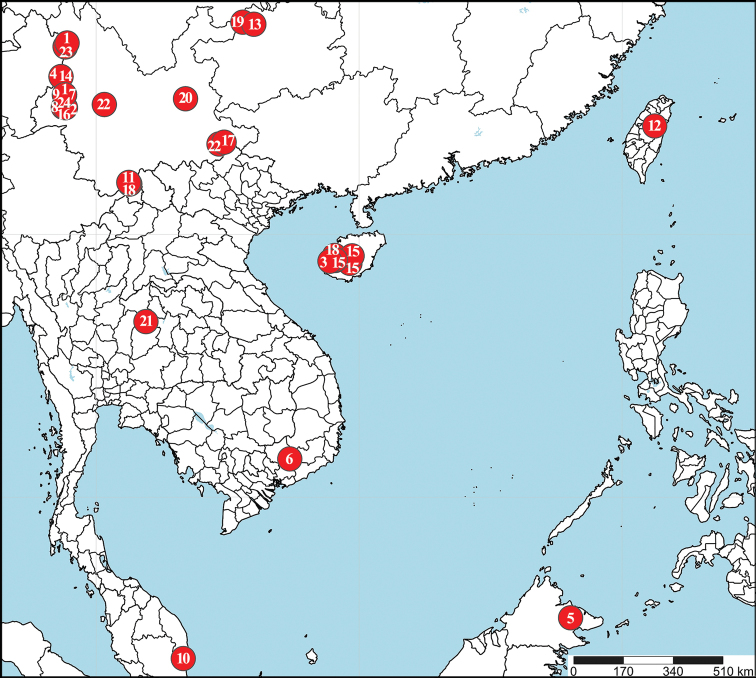
Distribution records of Crassignatha spp. in Asia. 1C.
baihua sp. nov. 2C.
bangbie sp. nov. 3C.
bicorniventris4C.
changyan sp. nov. 5C.
danaugirangensis6C.
dongnai sp. nov. 7C.
ertou8C.
gucheng sp. nov. 9C.
gudu10C.
haeneli11C.
mengla sp. nov. 12C.
nantou sp. nov. 13C.
nasalis sp. nov. 14C.
pianma15C.
quadriventris16C.
quanqu17C.
rostriformis sp. nov. 18C.
shiluensis19C.
shunani sp. nov. 20C.
si sp. nov. 21C.
thamphra sp. nov. 22C.
xichou sp. nov. 23C.
yamu24C.
yinzhi.